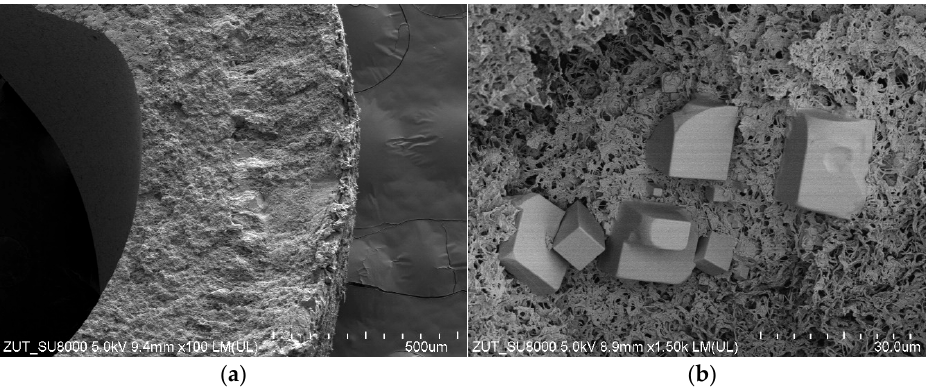
Figure 18. SEM images of the membranes used for the separation of NaCl solution (300 g/L) contaminated with oil (87– 112 mg/L): ( a ) membrane cross ‐ section; ( b ) NaCl crystals on the membrane surface. Module: SMD ‐ S6 ‐